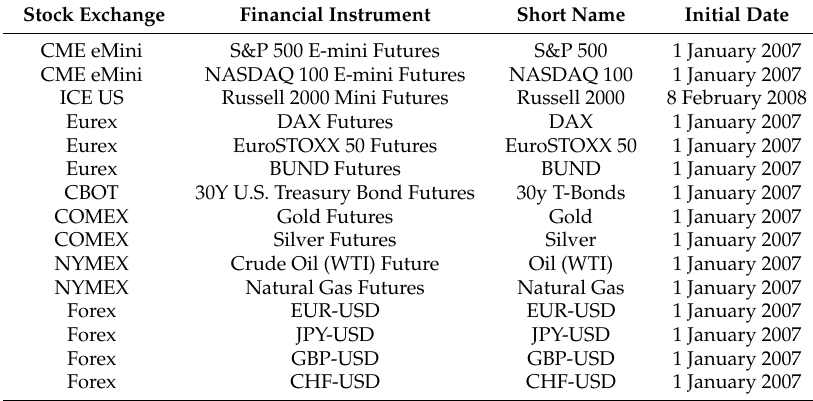
Table 1. Examined markets and the period of time of the used candle data of the 10min chart (whereas the initial date depends on the financial instrument, the terminal date is always 31 December 2015). The Forex data are from HistData.com while the rest of the historical data are from TaiPan RT from Lenz und Partner AG (Dortmund,